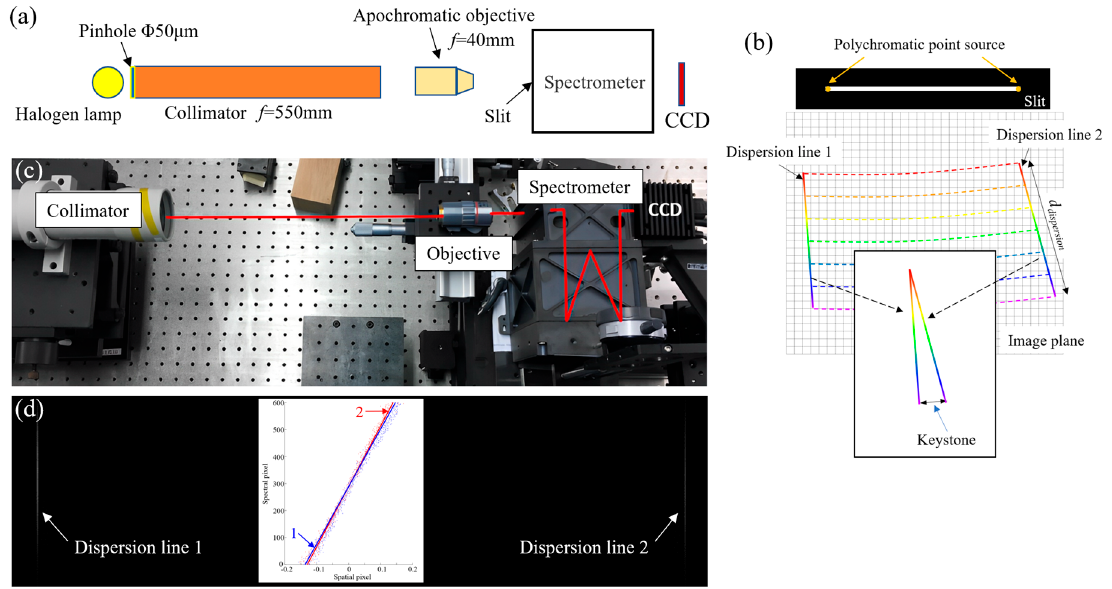
Figure 18. Test of keystone. ( a ) Schematic diagram of the test device, ( b ) the polychromatic point source is formed at both ends of the slit, and two dispersion lines are formed at the image plane, ( c ) the experiment device, and ( d ) dispersion lines corresponding to both ends of the slit.